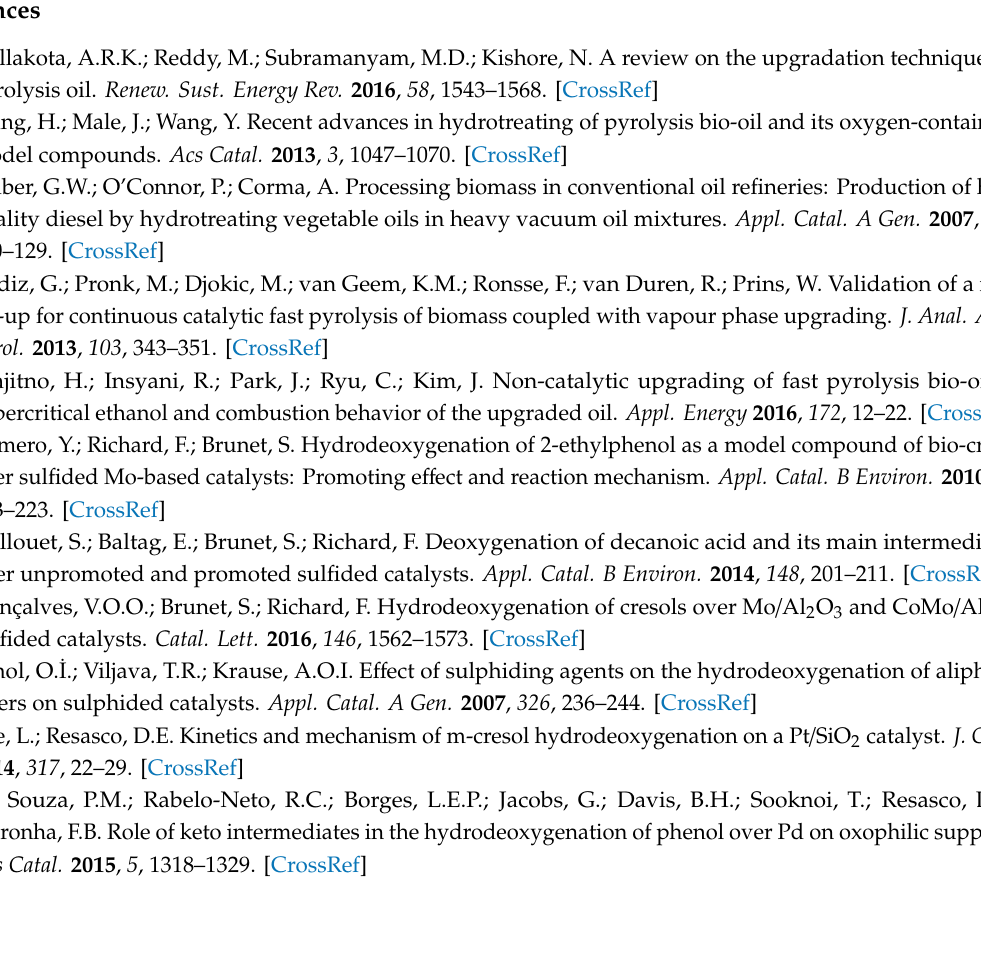
Figure S1: Total deoxygenated product yield of Ni x Cu (10 − x ) / γ -Al 2 O 3 catalysts at 8 h; Figure S2: Production distribution of Ni5Cu5 / γ -Al 2 O 3 catalyst with the reaction time on